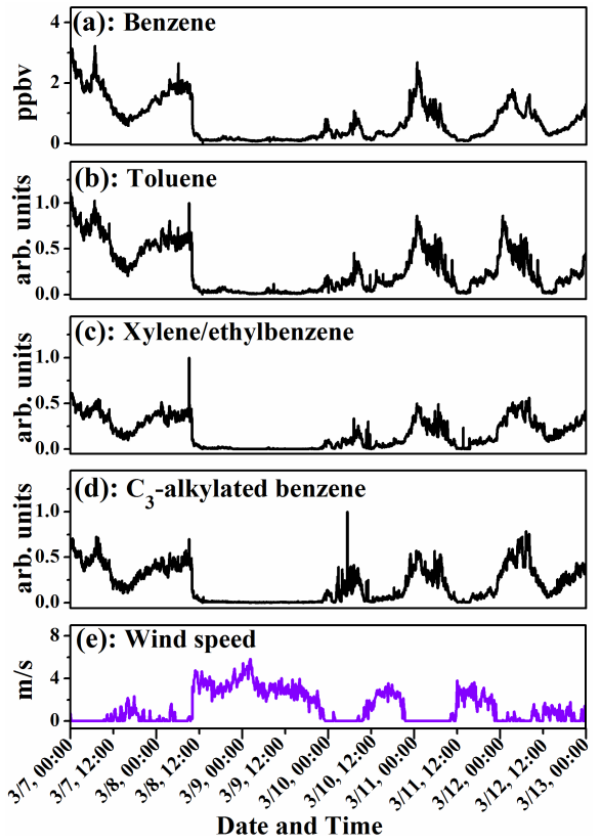
Figure 5. Outdoor measurements for 6 days: concentration varia- tion of benzene (a) , toluene (b) , xylene/ethylbenzene (c) , and C 3 - alkylated benzene derivatives (d) monitored by the